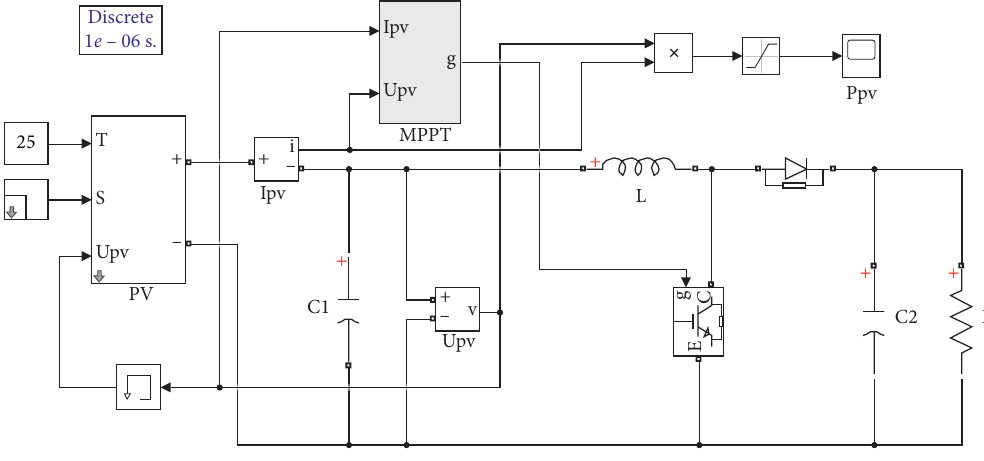
Figure 10: BOOST circuit simulation model. Table 2: BOOSTcircuit simulation model component